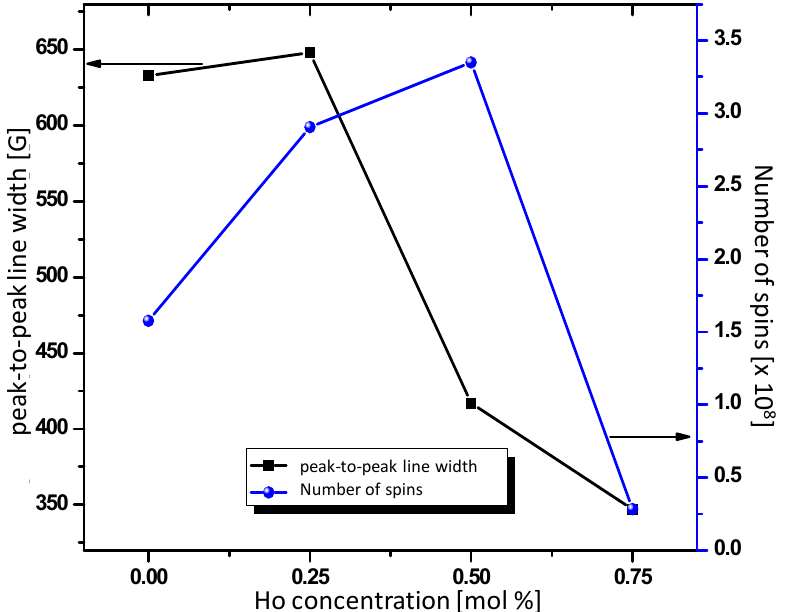
Figure 8. Peak-to-peak line width and number of spins as a function of Ho 3+ concentration.